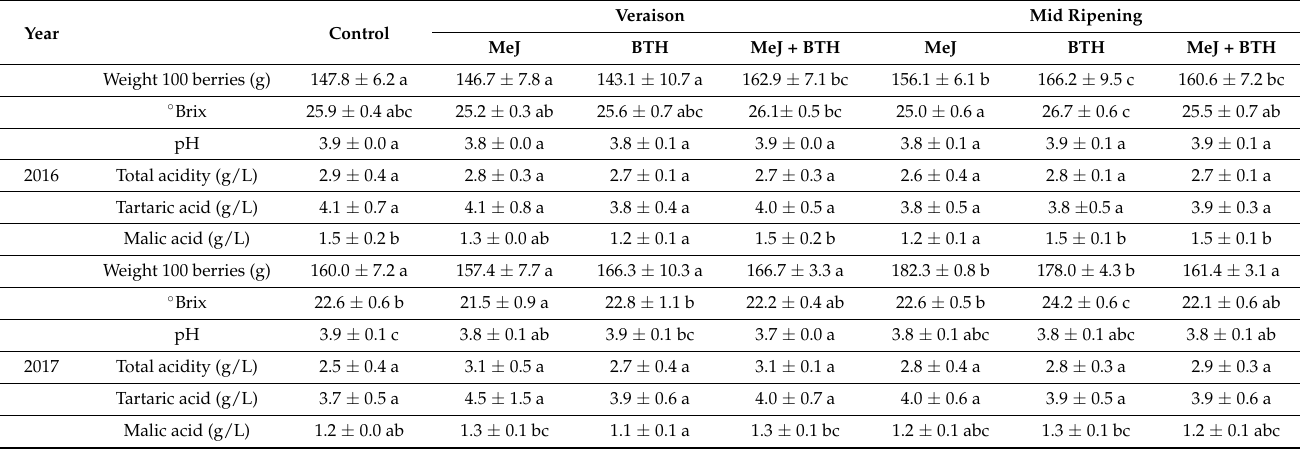
Table 1. Physicochemical characteristics of Monastrell grapes at harvest, treated with MeJ, BTH, and MeJ + BTH at two different application times: veraison and